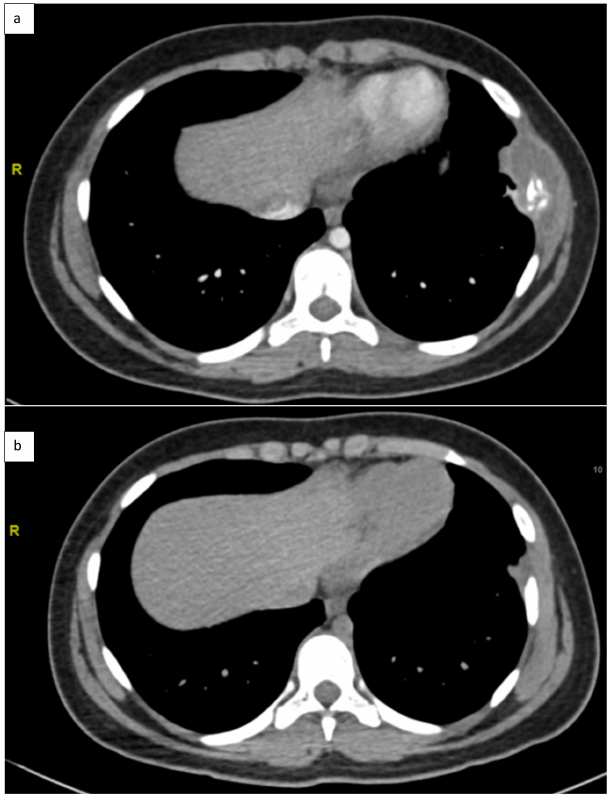
Figure 2. Thoracic CT scan (a) at diagnosis (b) end of treatment. Origin and source of radiology images: Department of Radiology CHU